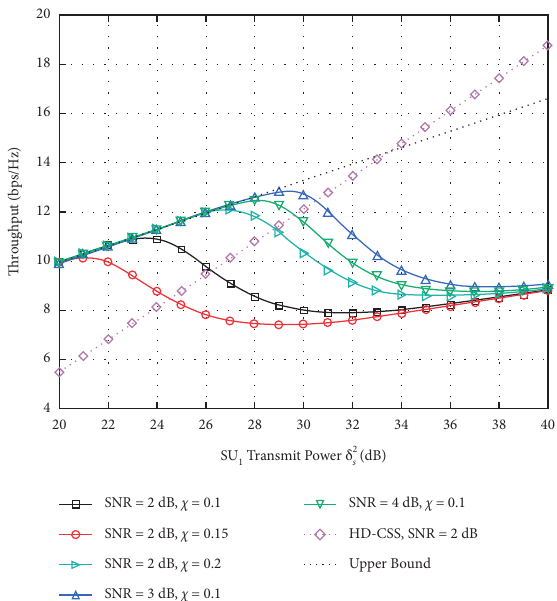
Figure 3: Throughput under different SNR.